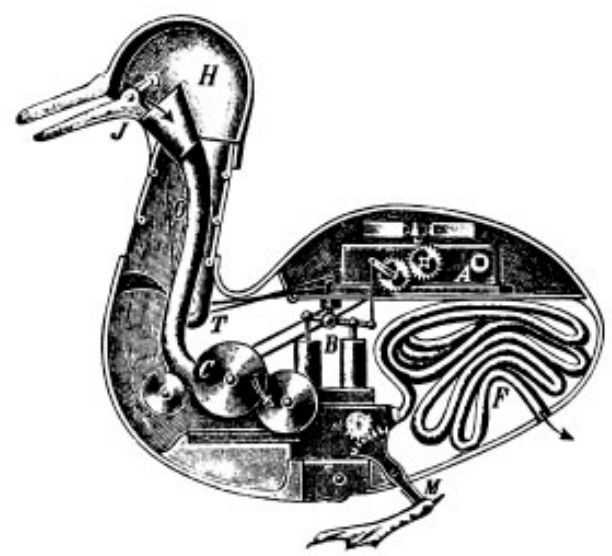
Figure 4. Jacques de Vaucanson’s “Digesting Duck.” Image in the public domain.